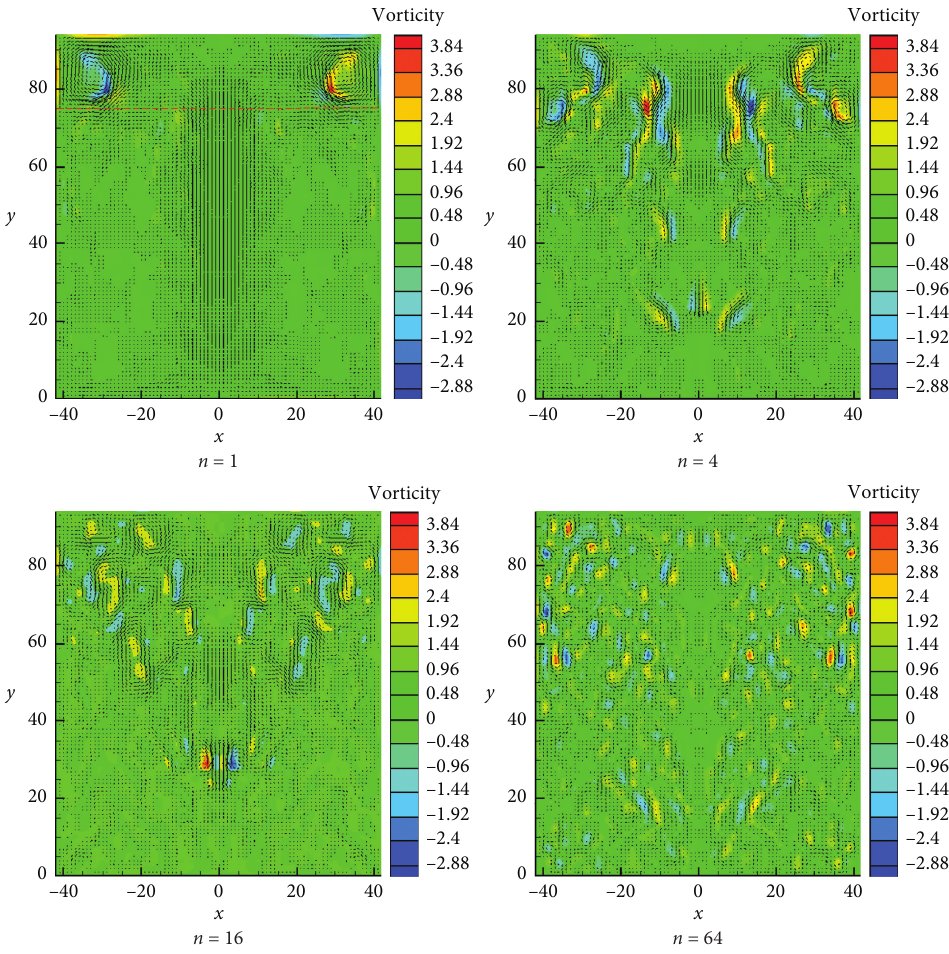
Figure 11: The single POD mode at 40g oscillation acceleration under 80% fill